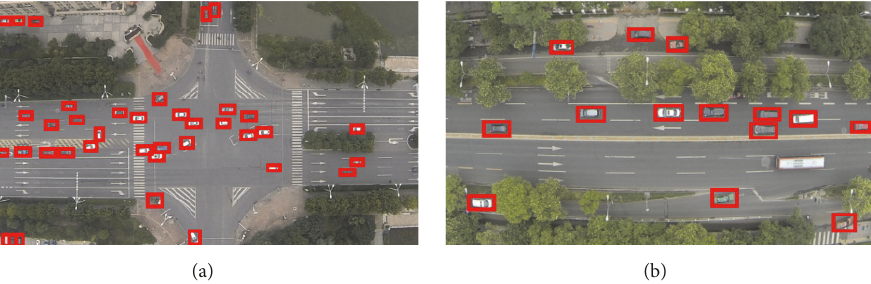
Figure 4: Car detection. (a) Signalized intersection; (b) arterial